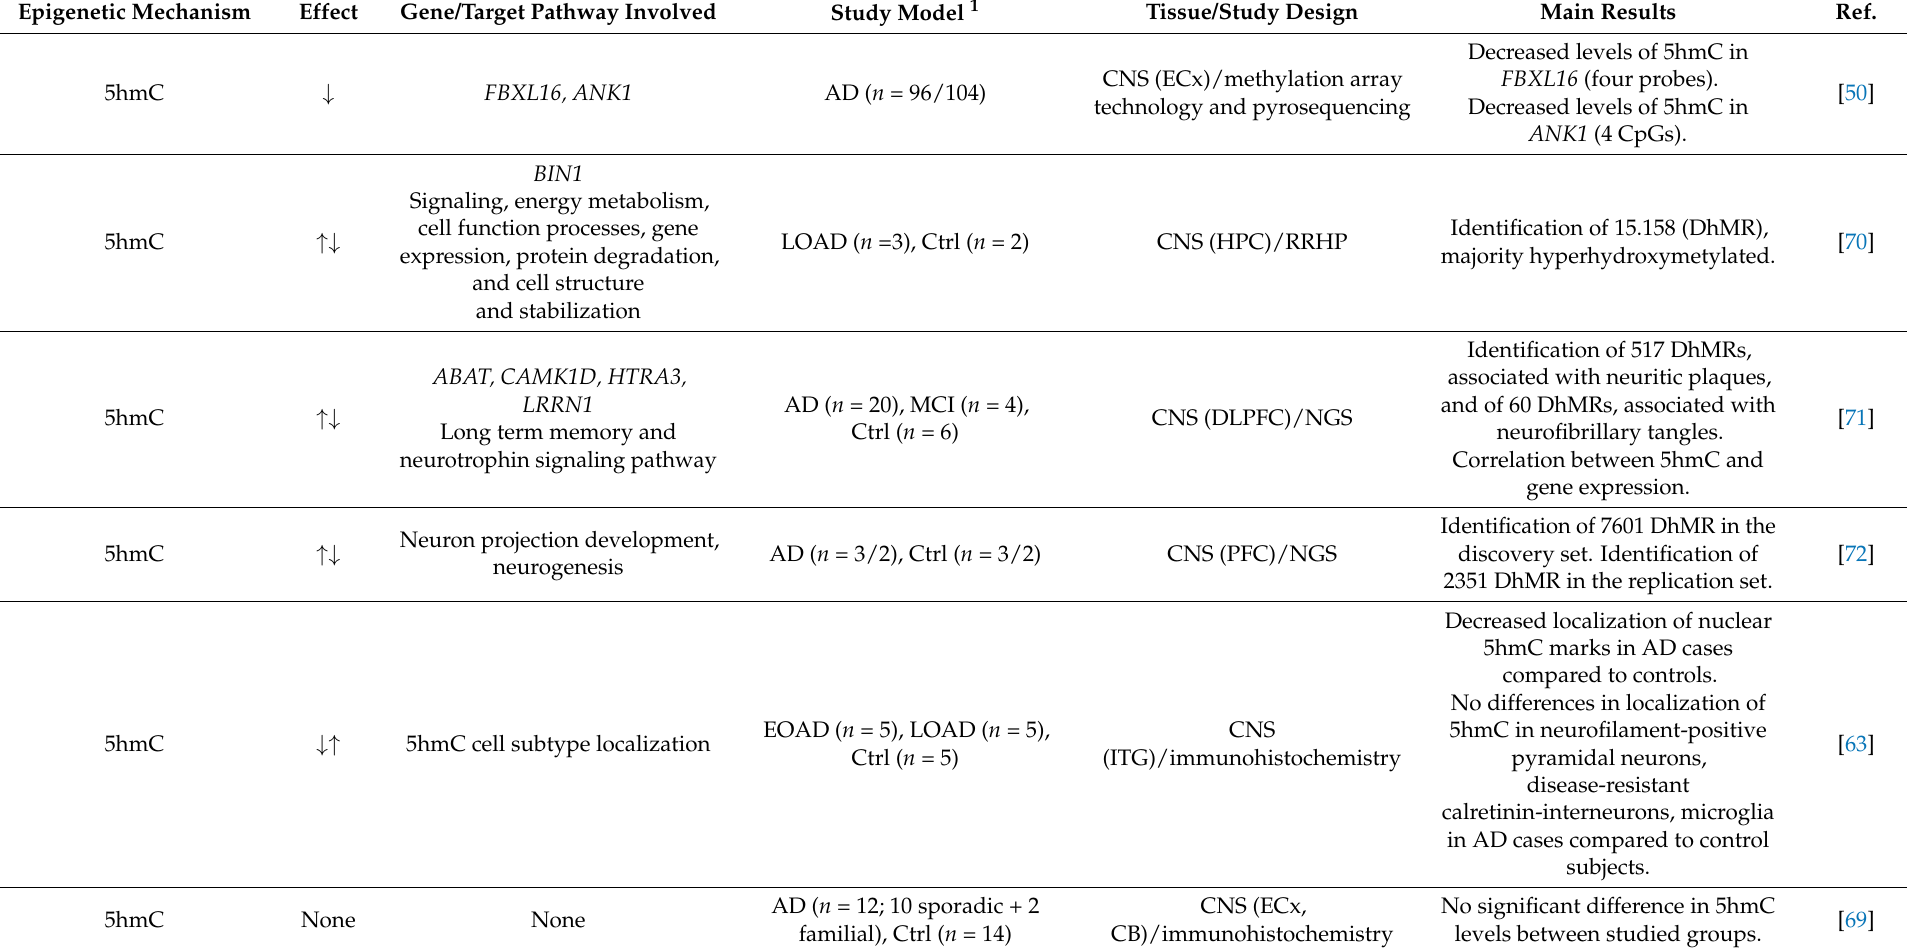
Table 2. Overview of studies investigating DNA hydroxymethylation in